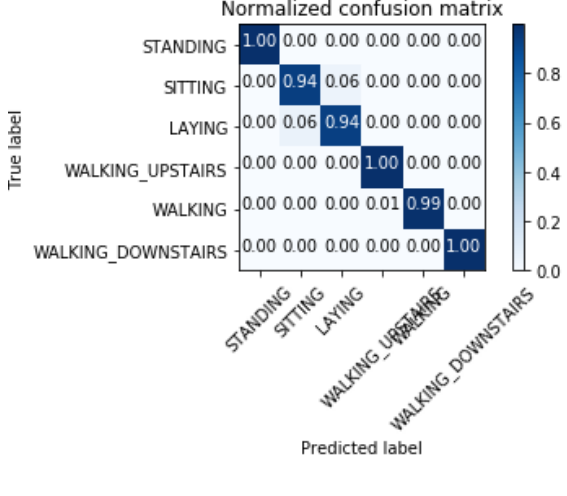
Figure 10. Graph of KNN at different values of k having different distances